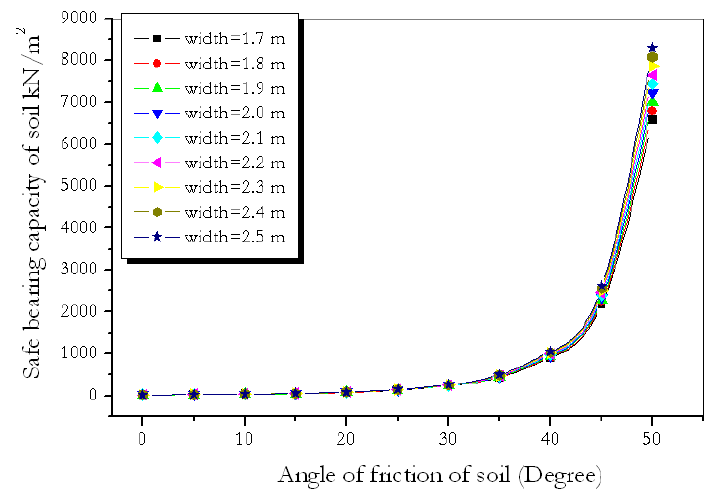
Figure 4: Safe bearing capacity Vs angle of friction of